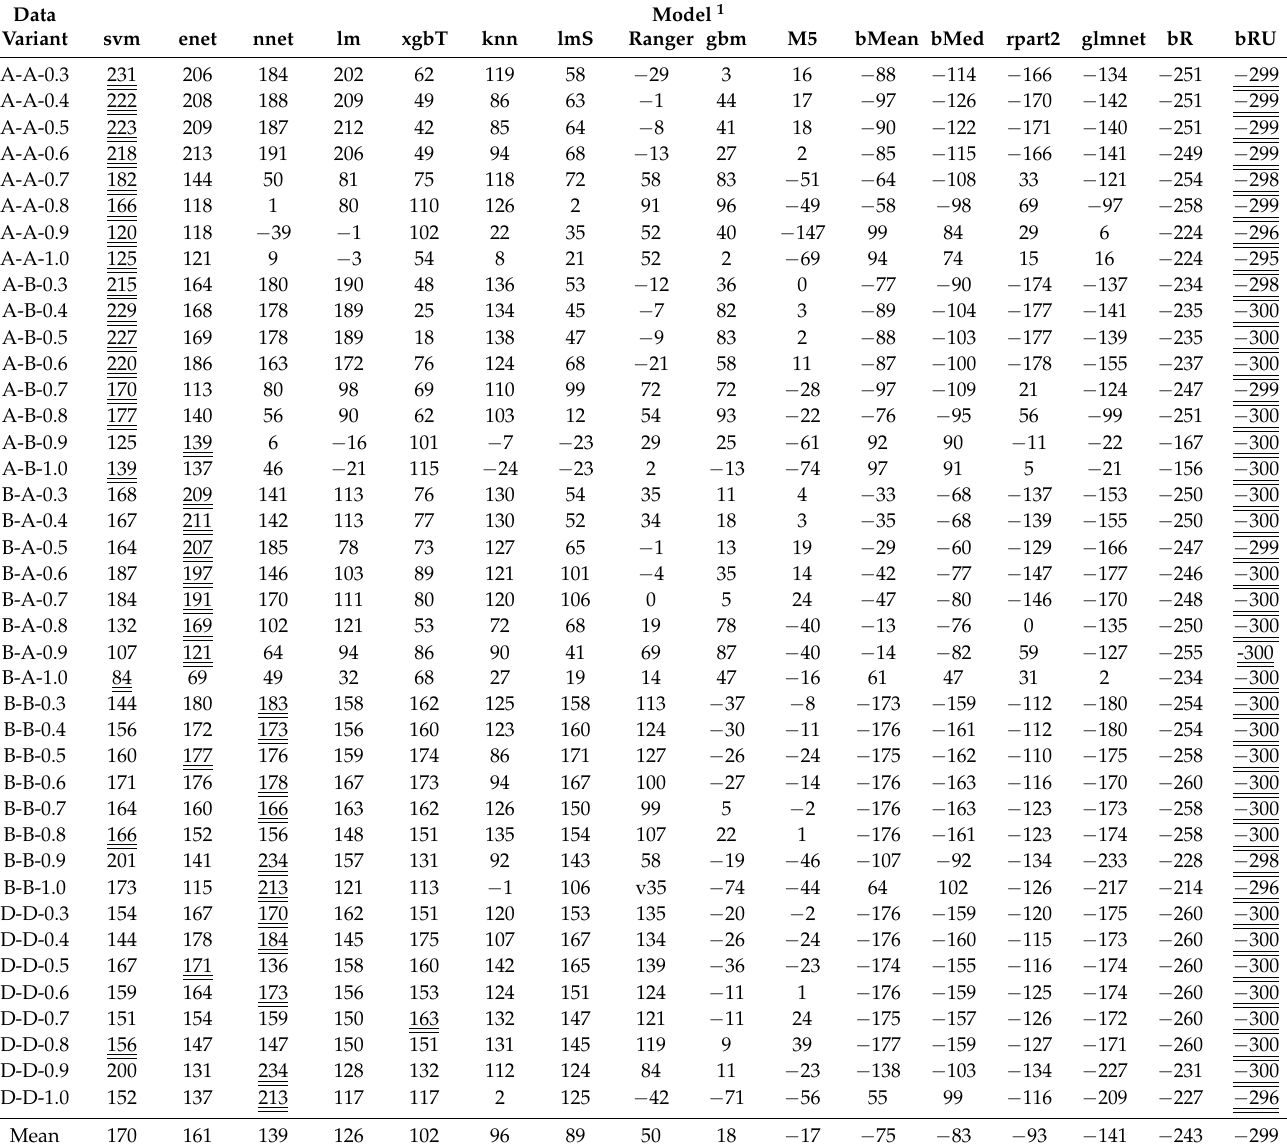
Table 6. The values of the difference of each model grouped by each data variant. The models in particular columns were sorted from the best to the worst, according to their mean difference across all data variants provided in the last row. The data variants in particular rows were sorted in alphabetical order. Values with a single underline denote the best model for a given data variant, and values with a double underline denote the worst model for a given data